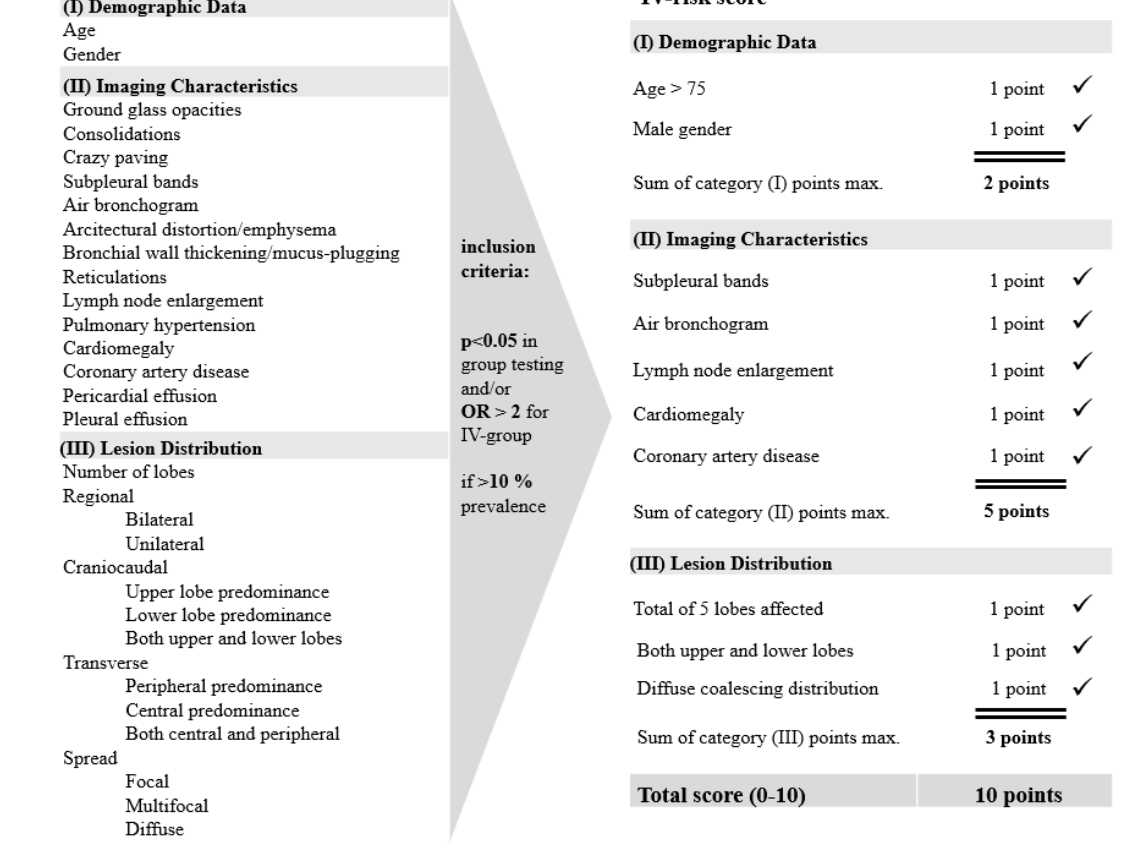
Figure 1. IV-risk score. Flow chart on the development of the IV-risk score with a range from 0–10 assessing the risk for invasive ventilation therapy. All parameters with significant test result ( p < 0.05) in group testing as well as parameters with odds ratios of >2 were included in the risk score. Parameters were included only if found in >10% of the patient population.